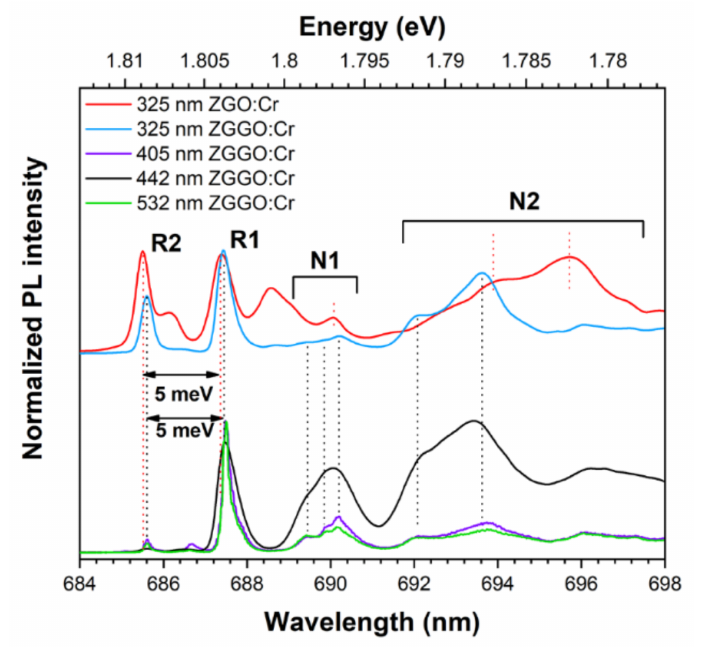
Figure 7. The 15 K PL spectra of ZGO:Cr and ZGGO:Cr samples on the enlarged scale of the high energy spectral region of Cr 3+